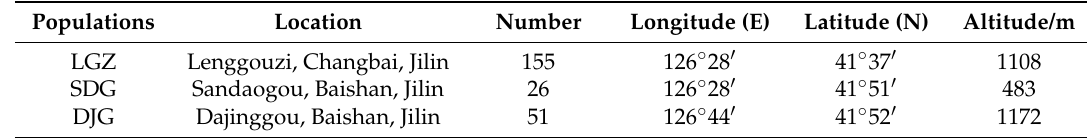
Figure 1. Geographic locations of the three natural populations of Thuja koraiensis . The map was created using the ‘maps’ and ‘mapdata’ package in R (v3.3.1, https://www.r-project.org/). Table 1. Location and sampling site characteristics for the three Thuja koraiensis populations.